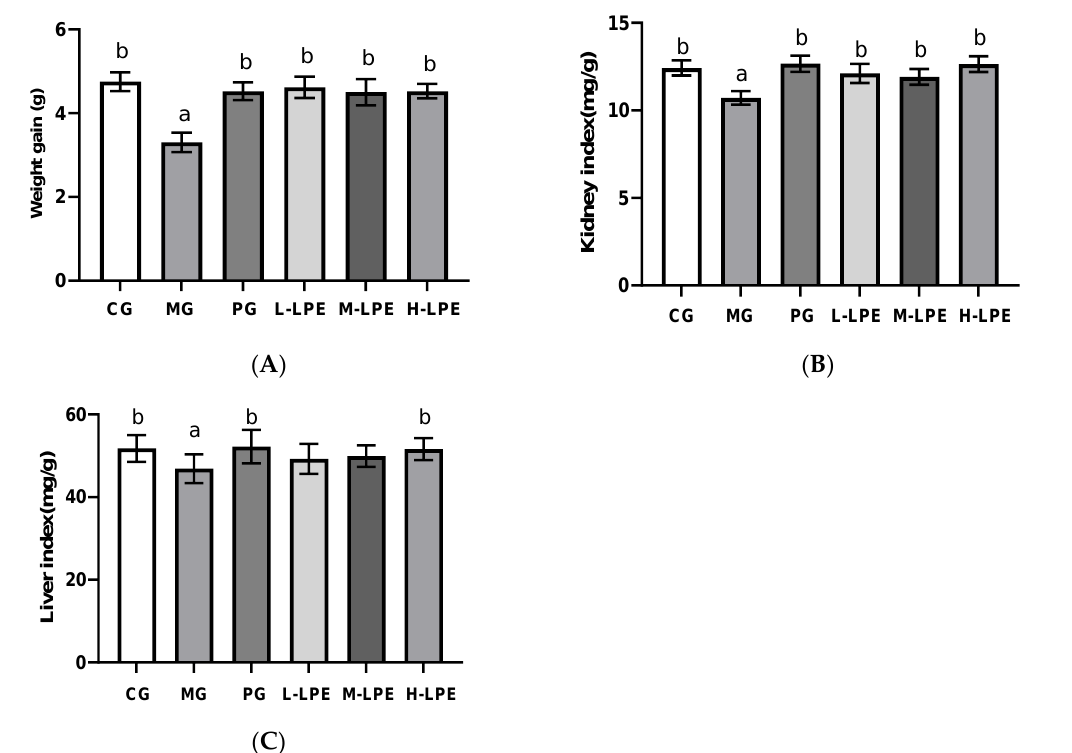
Figure 2. Effects of LPE on body weight, organ indexes in aging mice induced by D-galactose: ( A ) effects of LPE on body weight; ( B ) effects of LPE on kidney index; ( C ) effects of LPE on liver index. Values are expressed as mean ± standard error ( n = 12 in each group). Values with different superscripts showed a difference with statistical significance, p < 0.05, “a” as a statistical difference compared with the blank control group, “b” as a statistical difference compared with the model group.